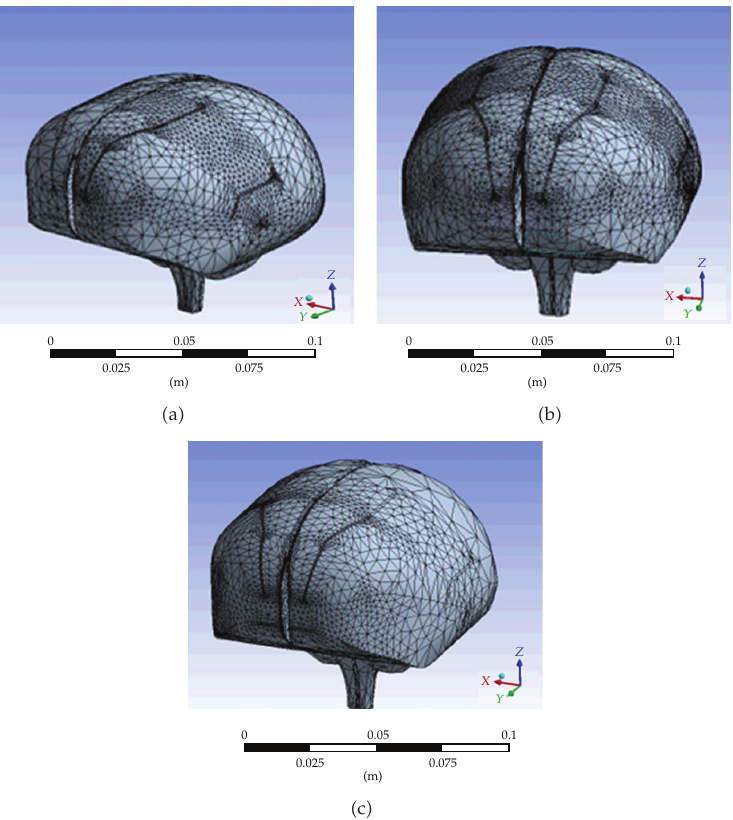
Figure 7: Isometric and superior views of the di ff erent computational grids of the brain model used for (cid:3) a (cid:4) parietal, (cid:3) b (cid:4) posterior, and (cid:3) c (cid:4) frontal craniotomy.